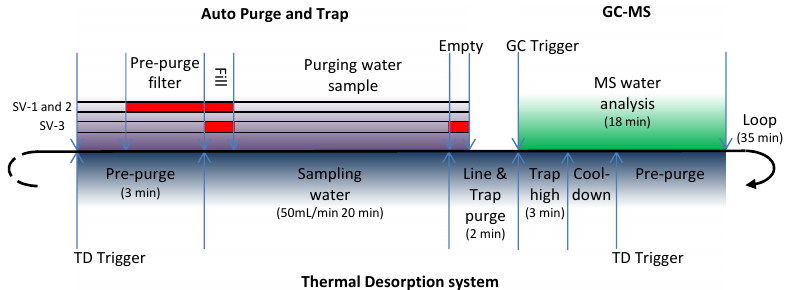
Figure 3. Graphical representation of the AutoP&T cycle (purple shading) beginning with the trigger from the thermal desorption cycle (blue shading) and its subsequent triggering of the GC-MS run (green shading).